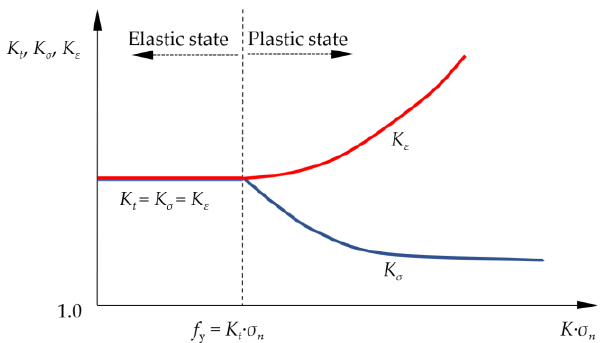
Figure 6. Stress and strain concentration factors in the elastic and plastic state.